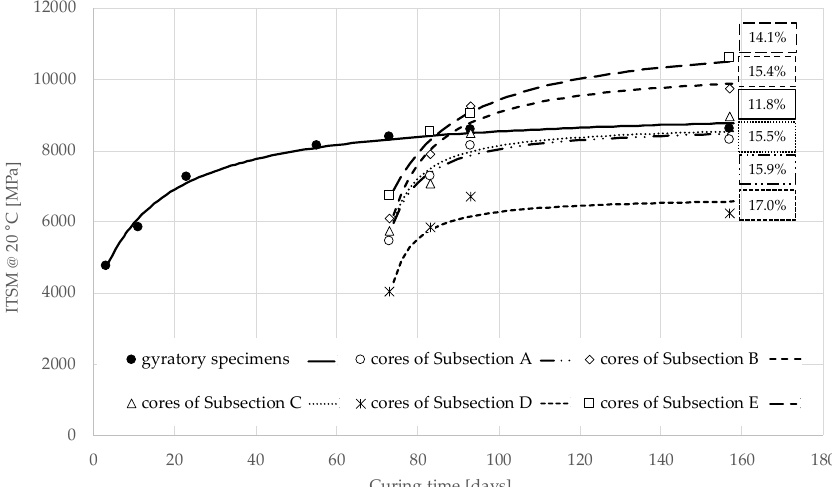
Figure 10. Measured data and model of the evolution of ITSM over curing time for specimens of Group 0 (gyratory) and Group 2 (cores).